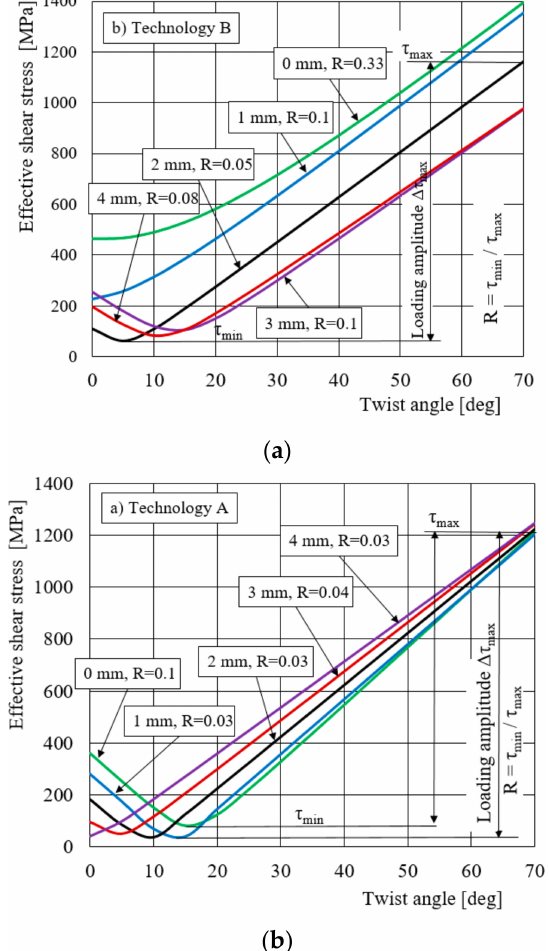
Figure 6. E ff ective maximum shear stress as a function of the test angle. ( a ) Technology A; ( b ) Technology